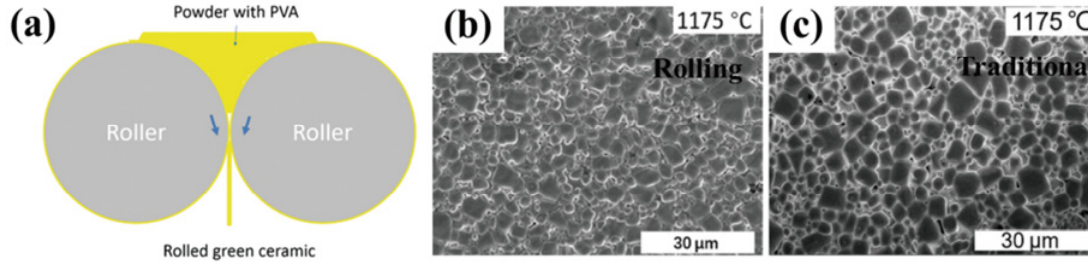
Fig. 22 (a) Schematic diagram of rolling process. SEM images of ceramics prepared via (b) rolling and (c) traditional method. Reproduced with permission from Ref. [48], © WILEY-VCH Verlag GmbH & Co. KGaA, Weinheim